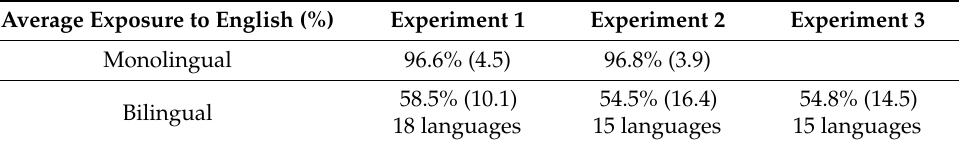
Table 3. Language exposure information for all experiments. Values represent the overall percent exposure to English (standard deviation). The number of unique languages that bilinguals were exposed to is also provided (note that each child heard only one of these languages; see Appendix A). Average Exposure to English